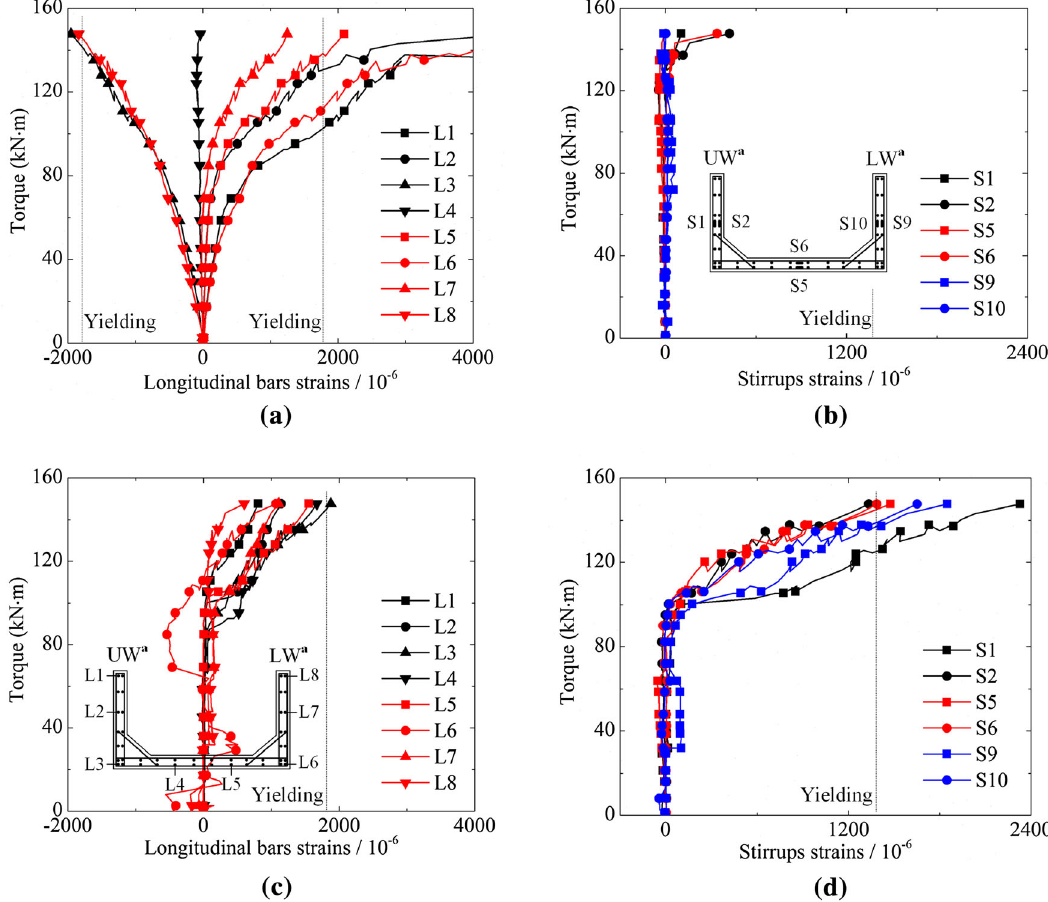
Fig. 11 Reinforcement strains of MEM-1:0. a Longitudinal bars strains at mid-span, b stirrup strains at mid-span, c longitudinal bars strains at quarter span, and d stirrup strains at quarter span. a The ‘‘LW’’ and ‘‘UW’’ mean ‘‘Loaded Web’’ and ‘‘Unloaded Web,’’ respectively.